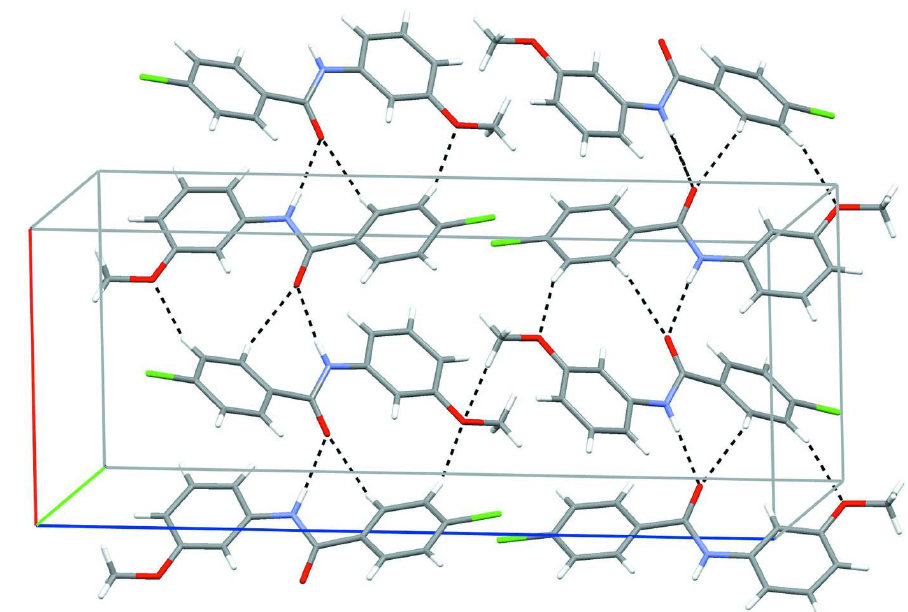
Figure 2 The two dimensional network in (I) formed by N—H···O and C—H···O